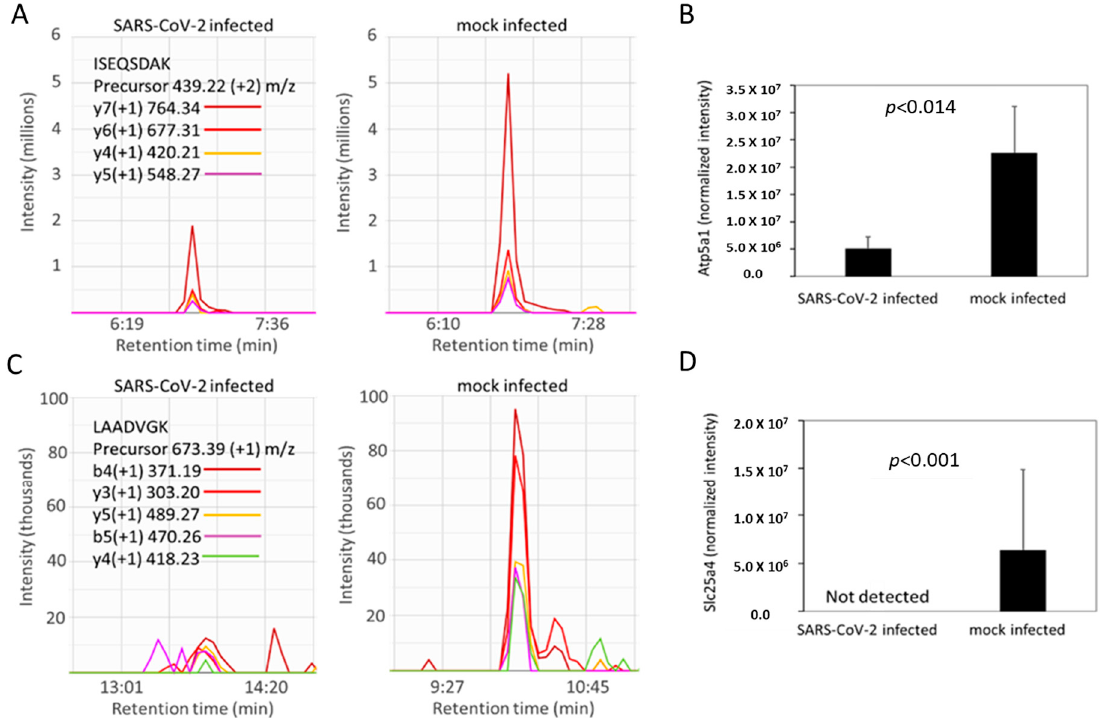
Figure 7. Atp5a1 (ATP synthase subunit alpha) and Slc25a4 (ADP/ATP translocase) are decreased in SARS-CoV-2-infected hamsters. ( A , C ) Representative MS2 spectra of infected versus control hamsters for a peptide assigned to Atp5a1 (panel ( A ), tryptic peptide sequence ISEQSDAK corresponding to residues 532–539 in UniProt accession number F1T2M2) and Slc25a4 (panel C , tryptic peptide sequence LAADVGK from residues 141–147 in UniProt accession number A0A1U7QFU8) in infected (left) versus control (right) hamsters. ( B , D ) Bar graphs show mean values for the mass spectrometry-based quantification of Atp5a1 from 21 peptides (panel ( B ) and Slc25a4 from 3 peptides panel ( D )). Statistical analysis was by a Student’s t test as described in the Methods. Error bars indicate SD.